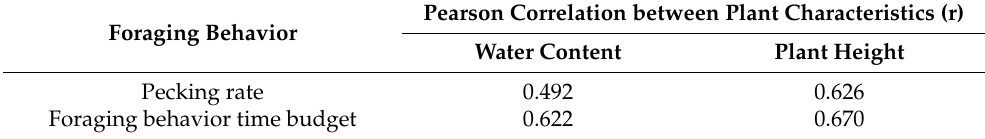
Table 1. Pearson correlation test results between plant characteristics and foraging